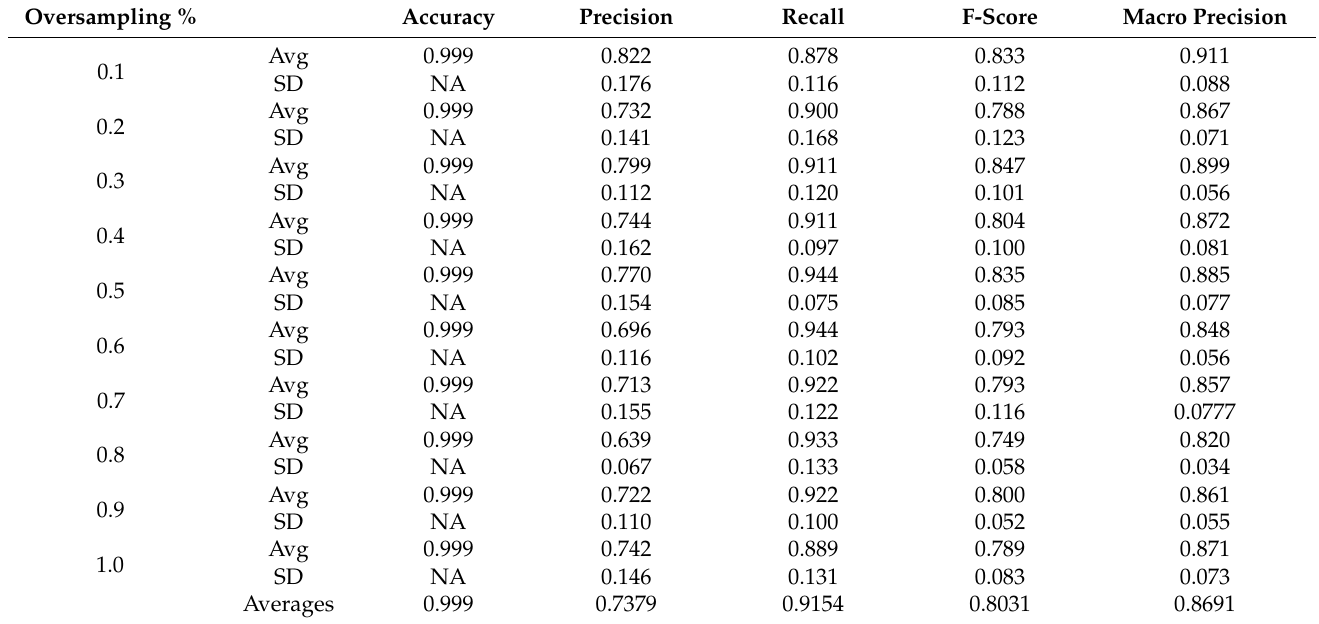
Table 21. UWF-ZeekData22: credential access—classification results for random undersampling after splitting.